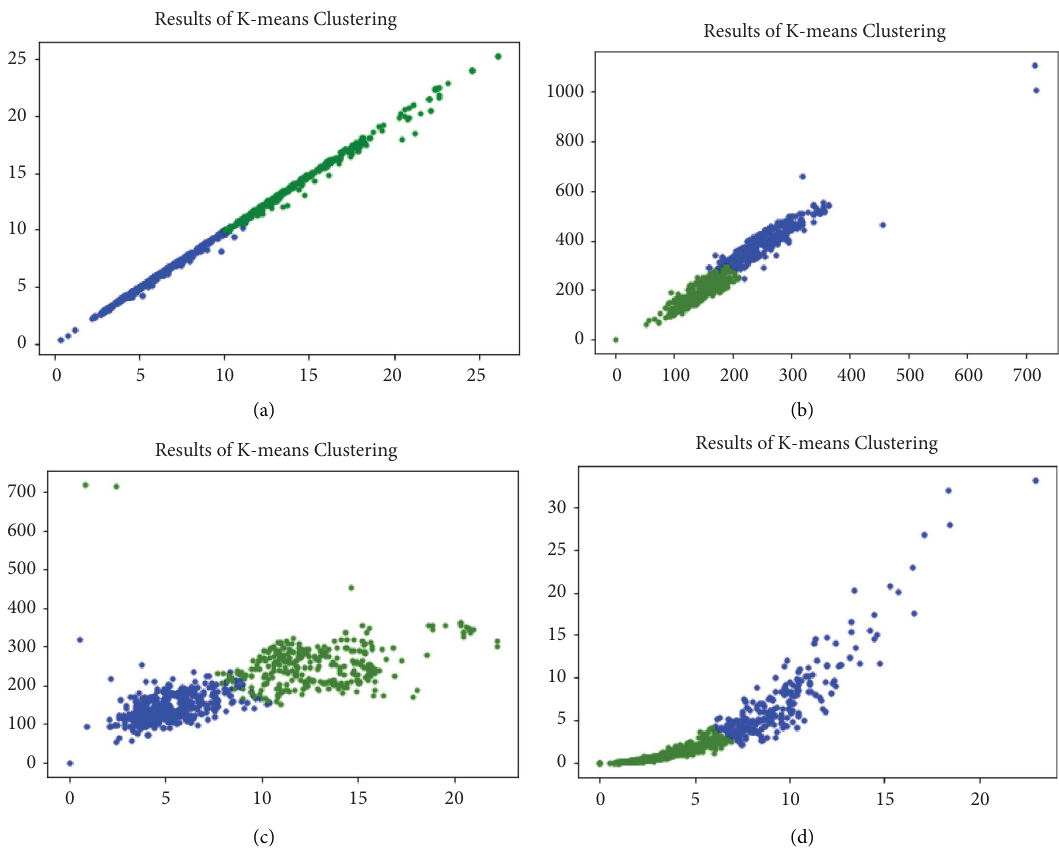
1 , (b) feature vector f 2 , (c) feature vector f 3 , and (d) feature